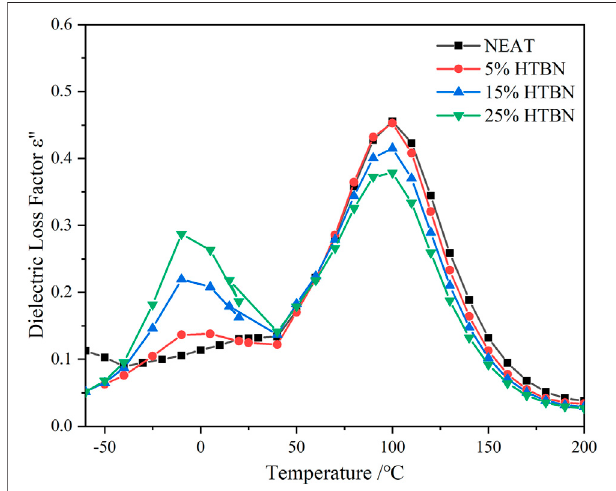
FIGURE 5 | Dielectric properties of different rubber contents at − 10 ° C.